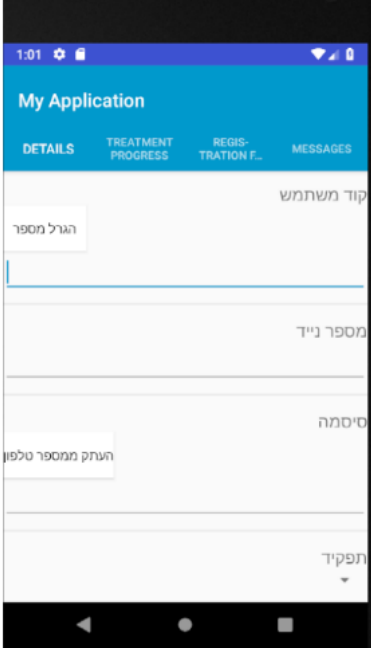
Figure 19. Patient screen for the dentist: the dentist may add a new patient.